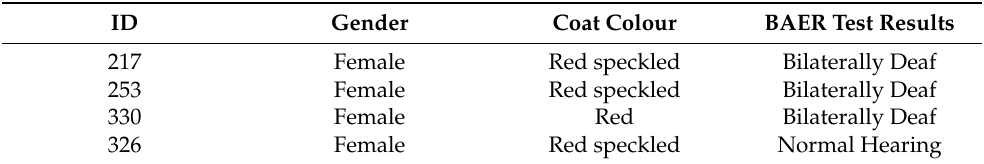
Table 1. BAER (brainstem auditory evoked response) results of 4 Australian Stumpy Tail Cattle Dogs (ASCDs). ID Gender Coat Colour BAER Test Results 217 Female Red speckled Bilaterally Deaf 253 Female Red speckled Bilaterally Deaf 330 Female Red Bilaterally Deaf 326 Female Red speckled Normal Hearing